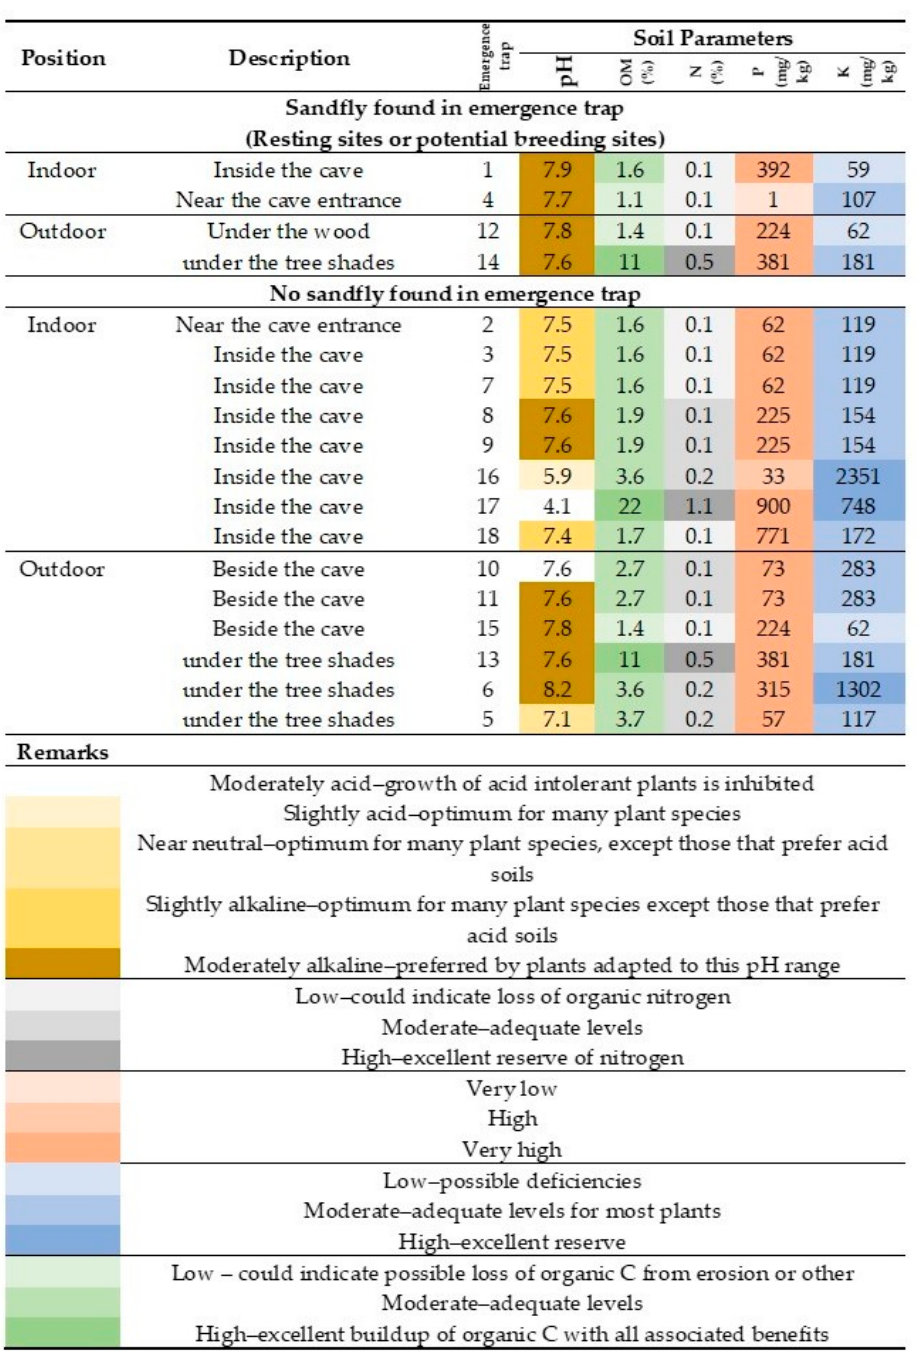
Table 4. Locations of sandfly resting sites or potential breeding sites Trap